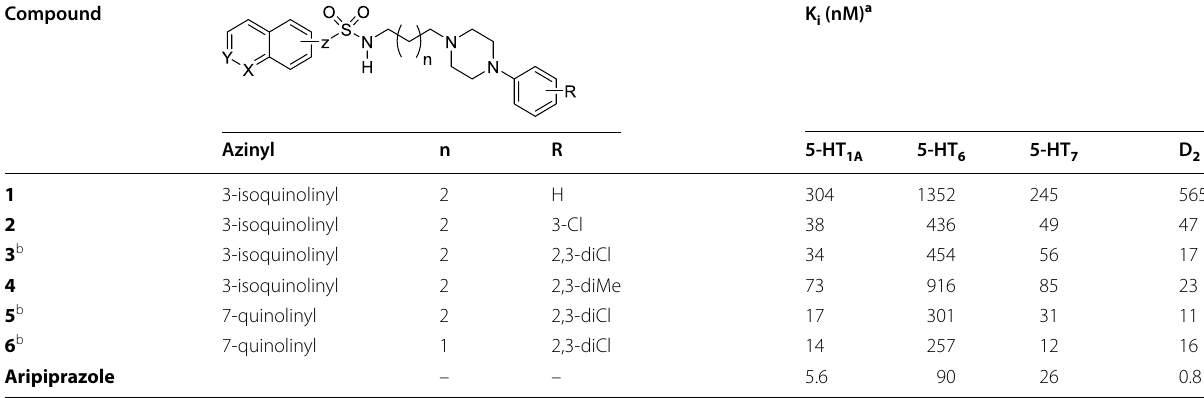
a Mean K i values (SEM ± 23%) based on three independent binding experiments b Data taken from Ref.